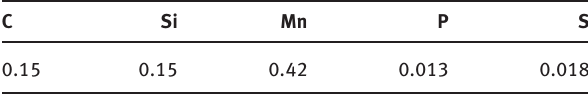
Table 1: Q235 grade steel composition, mass%.